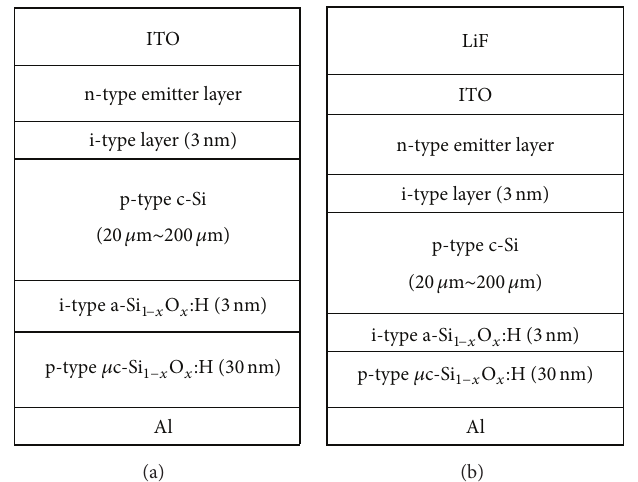
Figure 1: (a) The schematic structure of the c-Si heterojunction structure with single AR coating. (b) Heterojunction structure with additional layer of